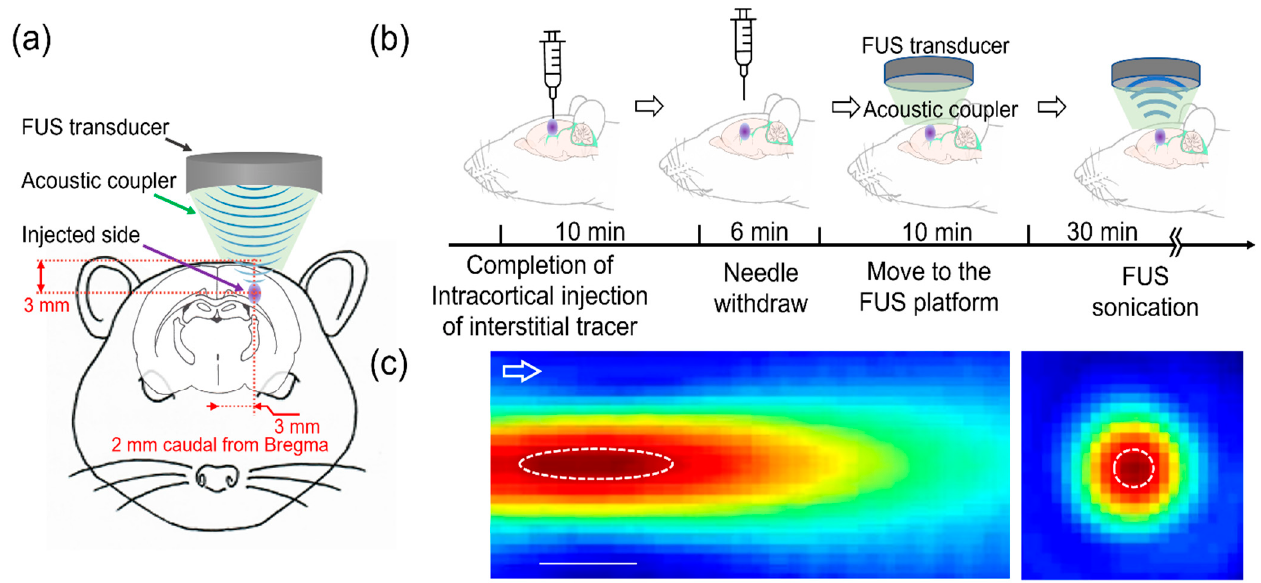
Figure 1. Schematics of the experimental procedure and the acoustic pressure map. ( a ) Descriptive drawing of the tracer injection site and sonication location. ( b ) Fluorescent tracers in artificial cere- brospinal fluid (aCSF) were intracortically injected and a focused ultrasound (FUS) was transcranially applied to the injected site. ( c ) Pseudo-color pressure map along the longitudinal and transverse plane of the FUS focus. The pressure contours defined at full width at 90% maximum are depicted by the dotted line (bar = 10 mm). The arrow indicates the direction of sonication.